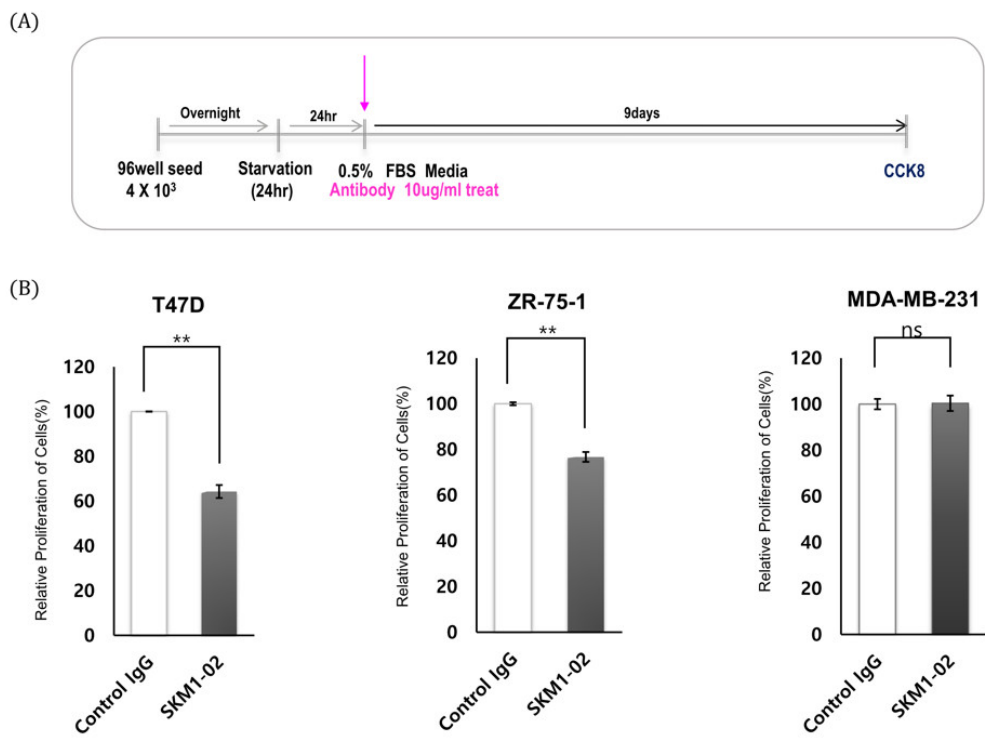
Figure 7. Effect of SKM1-02 antibody on proliferation of breast cancer cells. ( A , B ) T47D and ZR-75-1 cells (MUC1-positive) and MDA-MB-231 cells (MUC1-negative) were treated with the anti-hMUC1 monoclonal antibody 10 µg/mL or control IgG. Cell proliferation was evaluated using a CCK-8 assay on day 9 post-treatment. The data are based on 3 independent trials; ns: not significant ( p > 0.05). ** p ≤ 0.01.